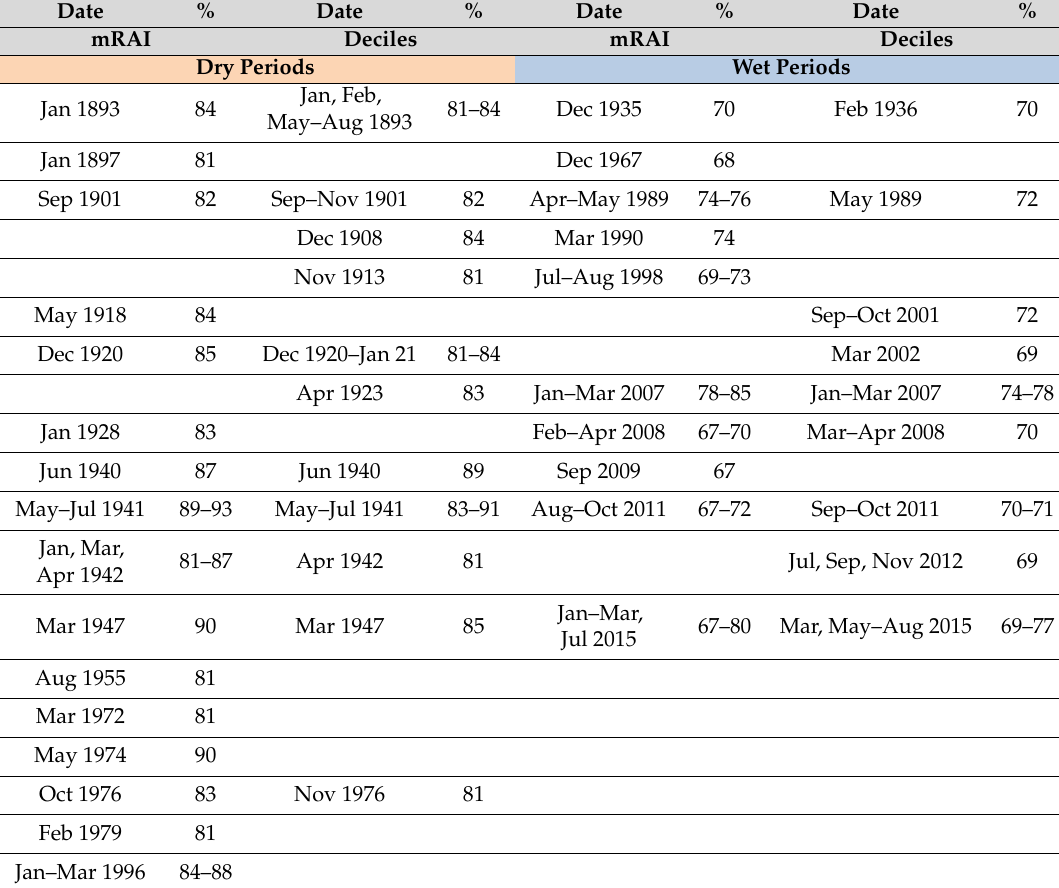
Table A2. Sub-region Scandinavia—overview on the TOP20 months with the highest spatial extent of dry and wet periods within the study period